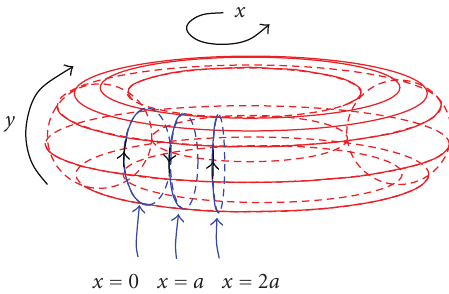
Figure 3.4. The 3 circles example. The metric is chosen so that the circles are parallel to each other. Optimal S can be either the region between the x = 0 and x = a circles or the region between the x = a and x = 2 a